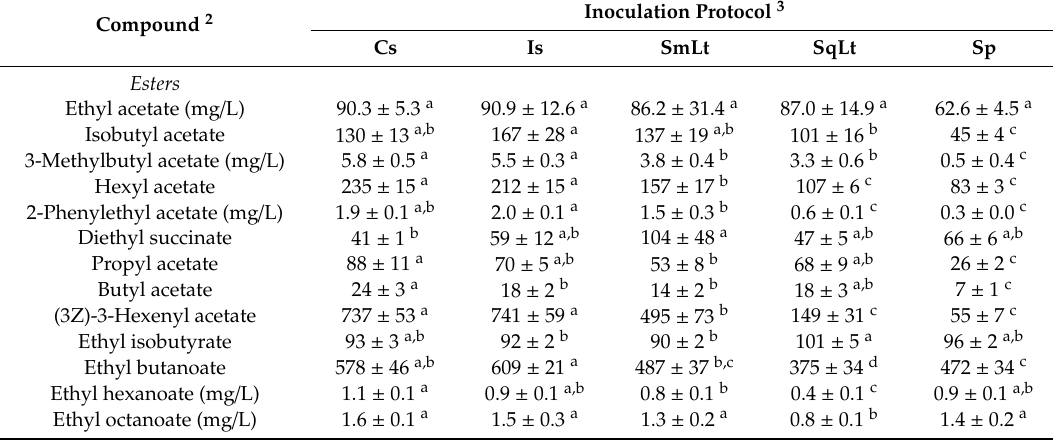
Table 5. Content of volatile compounds 1 in wines produced from natural grape must (mean ± SD, n = 3). Values with di ff erent superscript letters within each row di ff er significantly ( p <